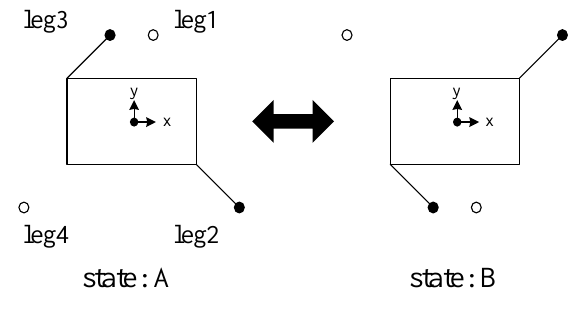
Figure 6. Trotting